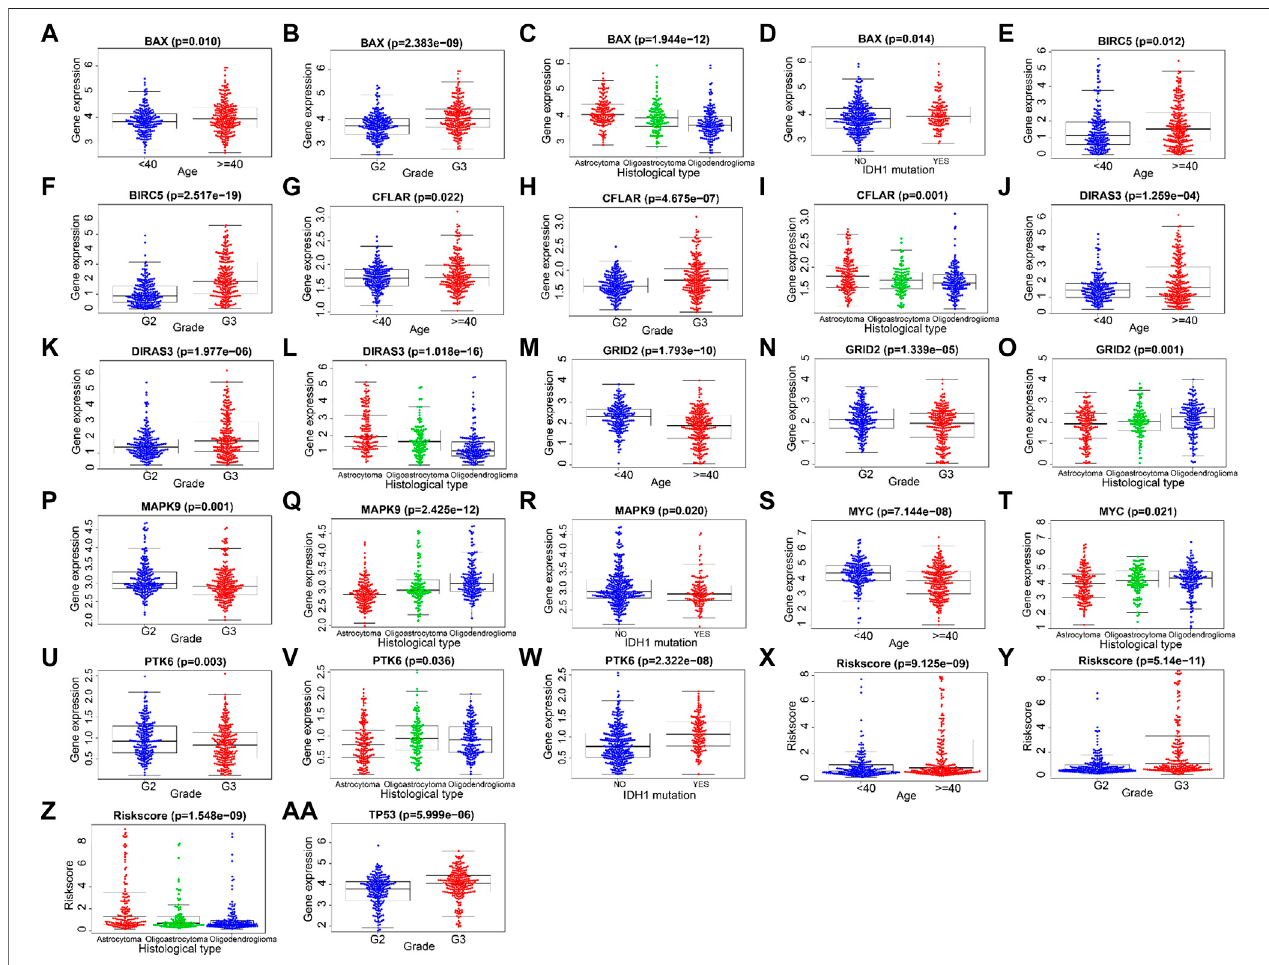
FIGURE 6 | Correlations between ARGs and clinical features.